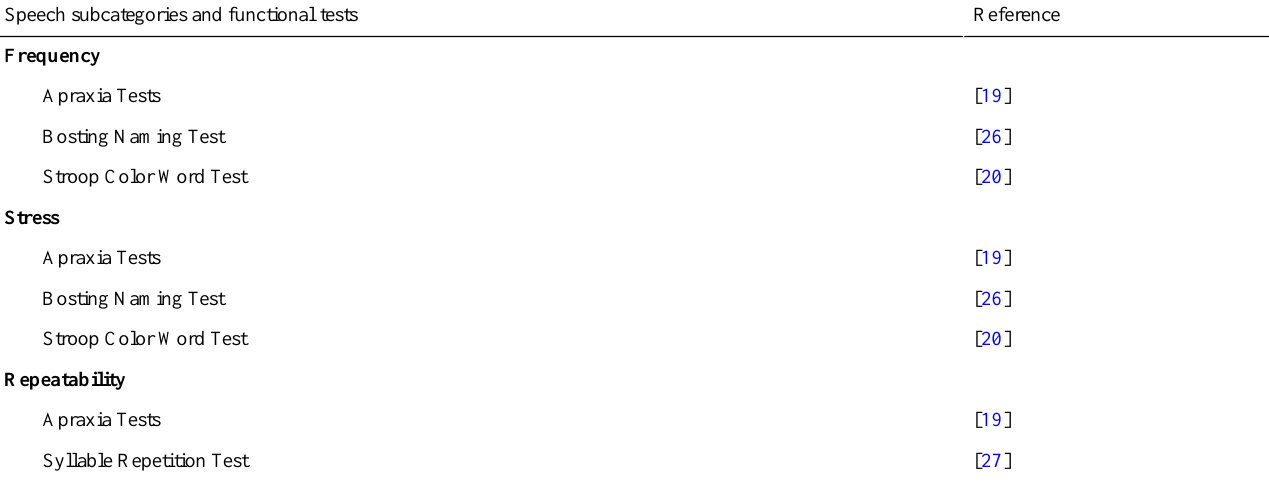
Table 7. Speech functional tests and assessment